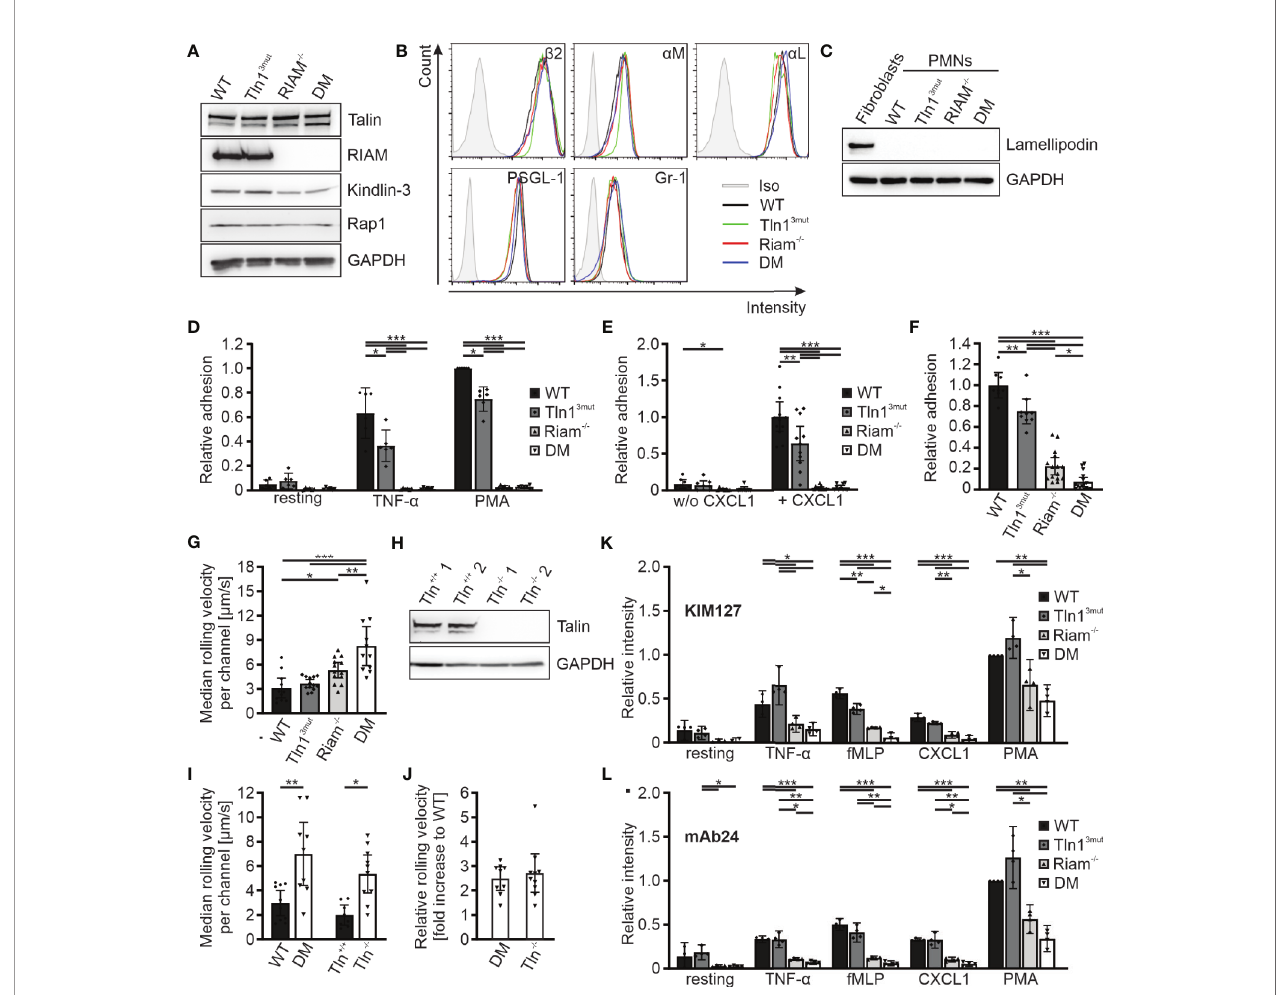
FIGURE 3 | Reduced integrin activity and function in Hoxb8 cell-derived Tln 3mut , Riam -/- and DM neutrophils. (A) Western blots showing Talin, Riam, kindlin-3 and Rap1 expression in Hoxb8 cells derived from WT, Tln1 3mut , Riam -/- and DM mice. GAPDH served as loading control. (B) FACS histograms showing surface levels of the integrin subunits b 2, a M and a L as well as PSGL-1 and Gr-1 of WT (black), Tln1 3mut (green), Riam -/- (red) and DM (blue) Hoxb8-derived neutrophils. (C) Expression of lamellipodin in Hoxb8-derived neutrophils assessed by Western blot. Mouse embryonic fi broblast lysate served as positive control, GAPDH as loading control. (D) Relative adhesion of WT, Tln1 3mut , Riam -/- and DM Hoxb8-derived neutrophils on ICAM-1 either unstimulated (resting) or upon stimulation with TNF a or PMA under static conditions (N = 6). (E – G) Rolling and adhesion behavior of WT, Tln1 3mut , Riam -/- and DM Hoxb8-derived neutrophils assessed in fl ow chamber experiments. (E) Relative adhesion under fl ow at a wall shear rate of 1 dyne/cm 2 on P-selectin and ICAM-1 (N = 8 chambers in 4 experiments) or P-selectin, ICAM-1 and CXCL1 coated surfaces (N = 12/11/12/10 chambers in 4 experiments). (F) Relative adhesion under fl ow at a wall shear rate of 0.3 dyne/cm 2 on P-selectin, ICAM and CXCL1 coated surfaces: WT values are set to 1 (N = 8/9/15/16 chambers in 3 experiments). (G) Rolling velocities of Hoxb8-derived neutrophils at a shear rate of 1 dyne/cm 2 (N = 11/13/13/11 chambers in 4 experiments). (H) Western blot analysis of Talin and GAPDH expression in Tln1 +/+ and Tln1 -/- Hoxb8 clones. (I, J) Median rolling velocities of WT and DM as well as Tln1 +/+ and Tln1 -/- Hoxb8-derived neutrophils assessed in P-selectin, ICAM-1 and CXCL1 coated fl ow chambers under 1 dyne/cm 2 shear stress. Results are shown as absolute values (I) and fold rolling velocity increase of DM and Tln -/- cells to respective WT controls (J) . Two Tln1 +/+ and Tln1 -/- clones were analyzed (N = 10/9/8/10 chambers in 2 experiments). (K, L) FACS analyses of integrin b 2 activation by measuring staining intensities of conformation speci fi c antibodies KIM127 (K) and mAb24 (L) normalized to total integrin b 2 levels on Hoxb8-derived neutrophils expressing human b 2 integrin either in resting state or in response to TNF- a , fMLP, CXCL1 or PMA. Values of PMA-stimulated WT cells were set to 1 (N = 4 experiments). All values represent mean ± 95% con fi dence interval. Statistical signi fi cance was assessed using ANOVA followed by Tukey ’ s multiple comparison test. *p < 0.05, **p < 0.01, ***p <